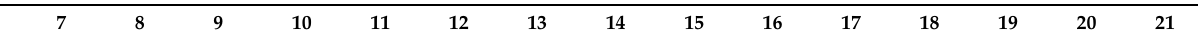
Table 1. Means, Standard Deviations, and Correlations of the